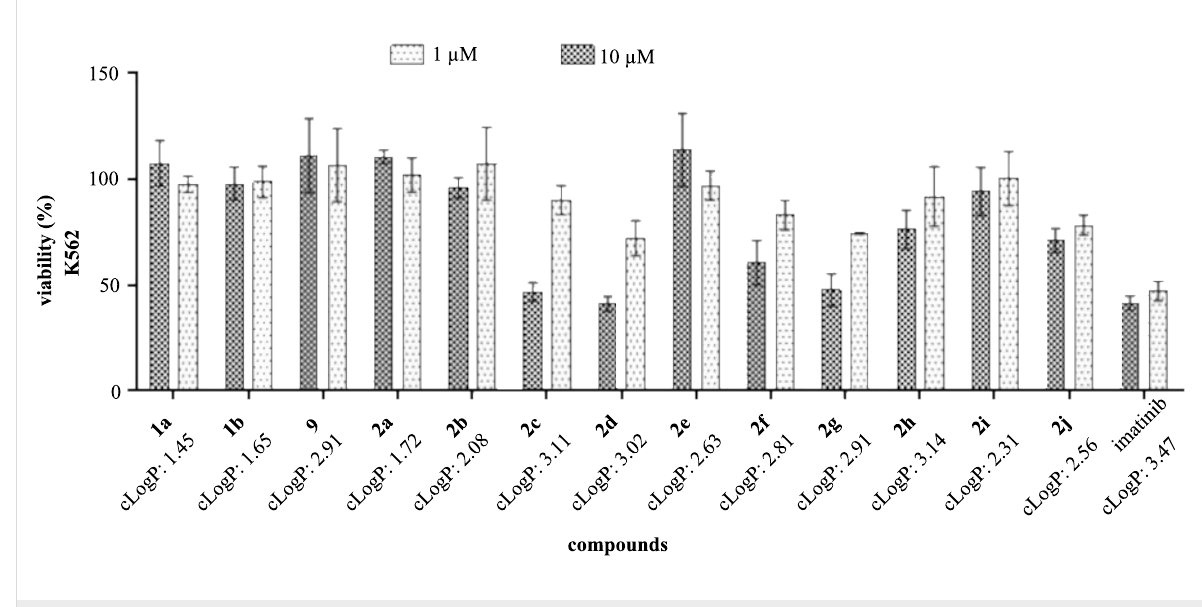
Figure 3: Screening of the triazole derivatives of imatinib 1a , b , and 2a–j at concentrations of 1 μ M and 10 μ M against the human K562 cell line. Bars represent the mean ± standard deviation. The standard used was IMT.